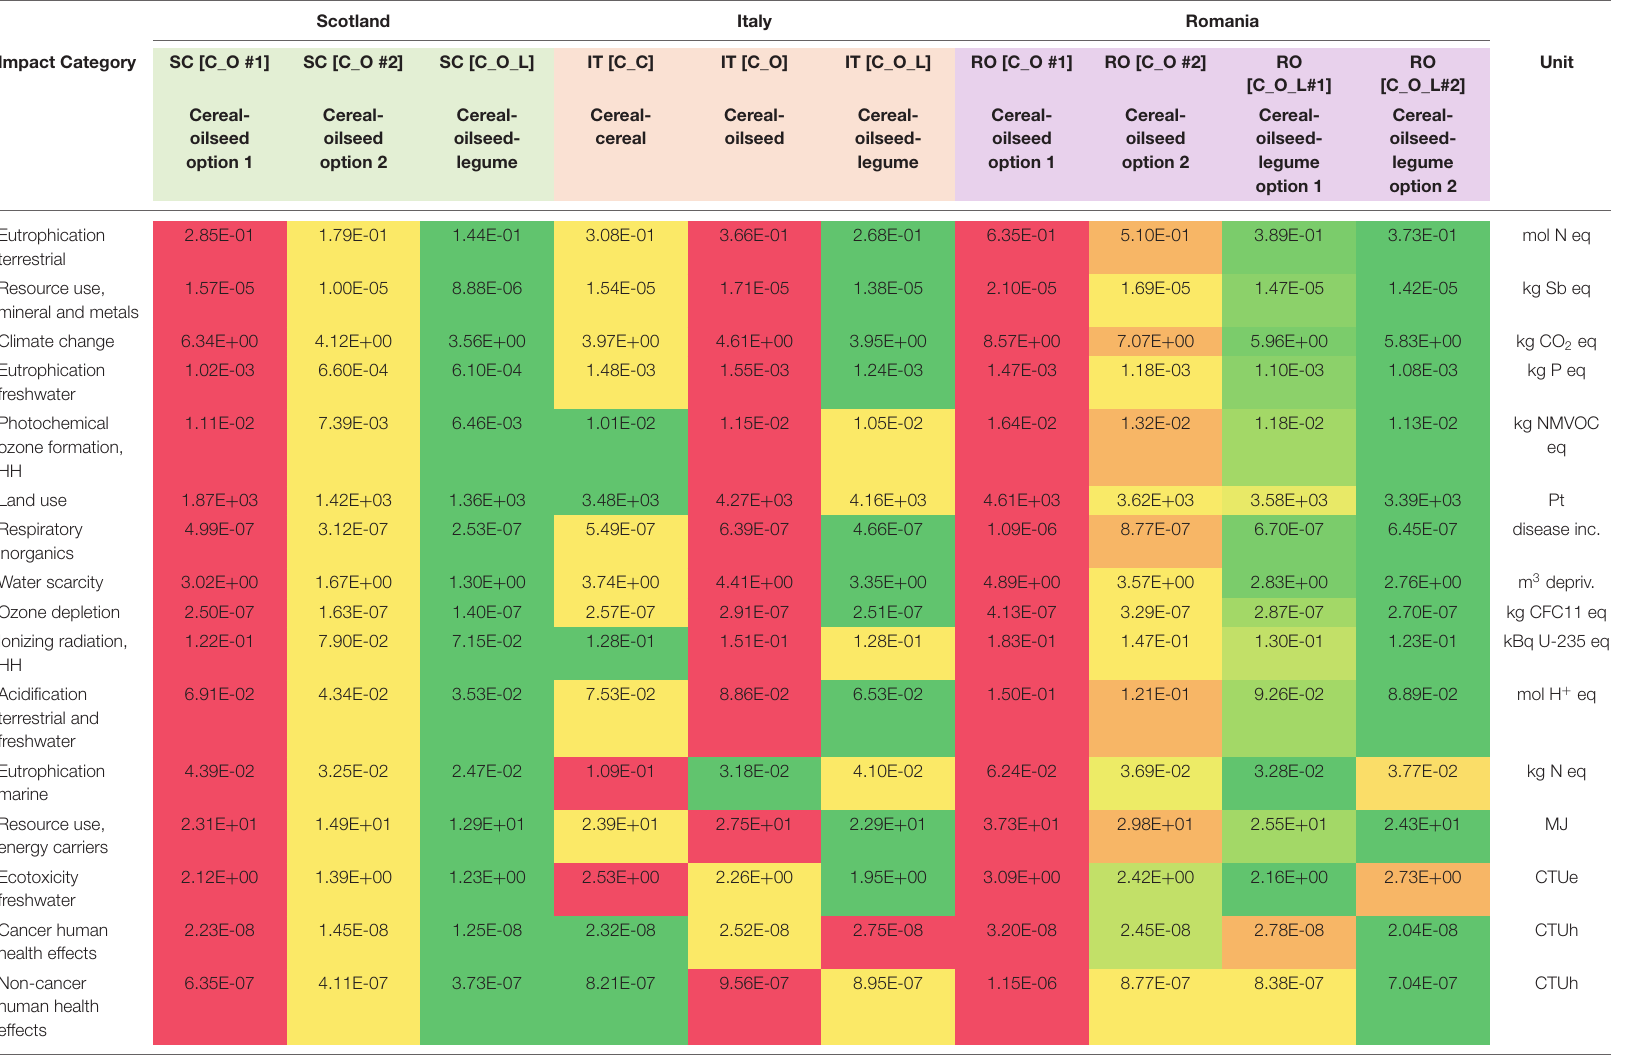
For each impact category and each region, the result for the rotation configuration with the highest impact is shaded darker red and the result for the rotation with the lowest impact is shaded darker